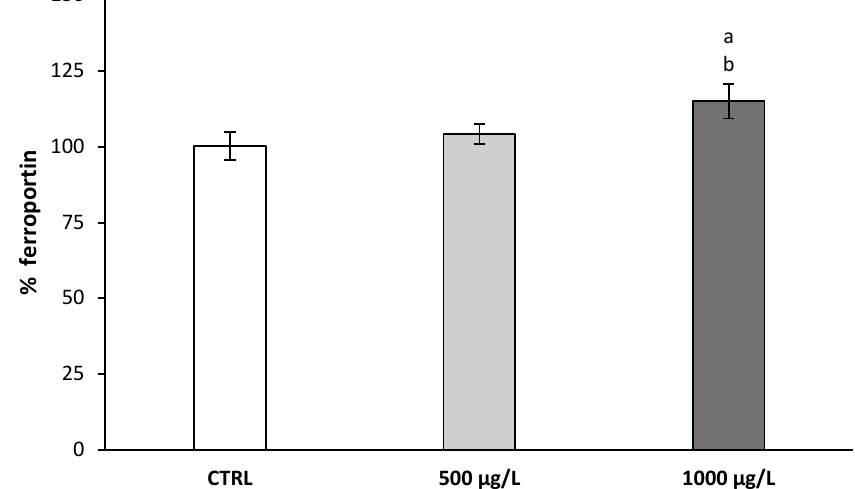
Table 4. Hematological parameters on day 35.